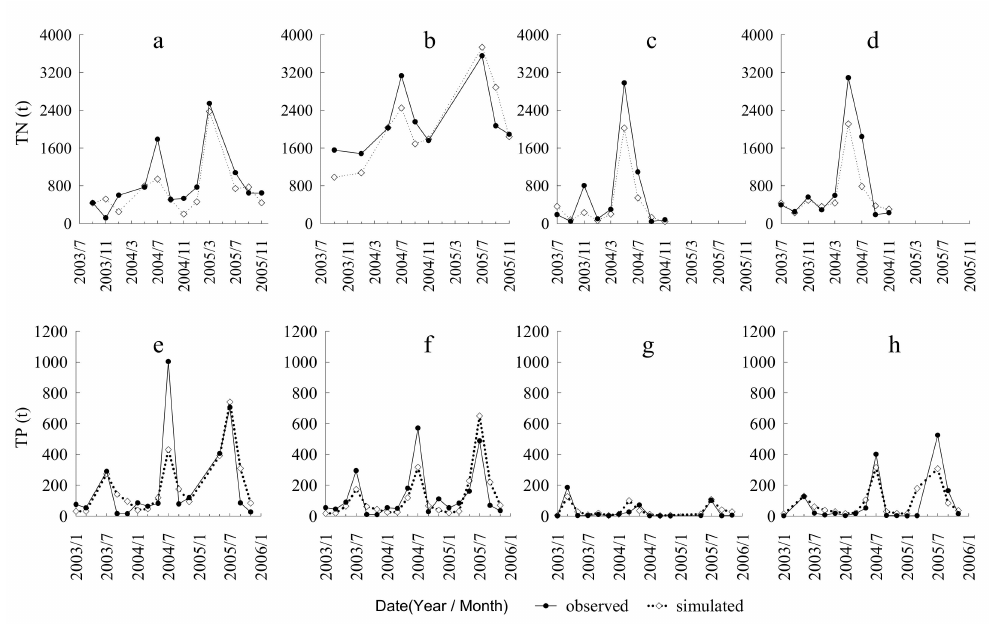
Figure 5. Comparison between the observed and simulated monthly nutrient yield at four stations for the calibration period (2003–2004) and validation period (2005). ( a ) Shenyang station; ( b ) Xingjiawopeng station; ( c ) Liaoyang station; ( d ) Xiaolinzi station; ( e ) Shenyang station; ( f ) Xingjiawopeng station; ( g ) Liaoyang station; ( h ) Xiaolinzi station.